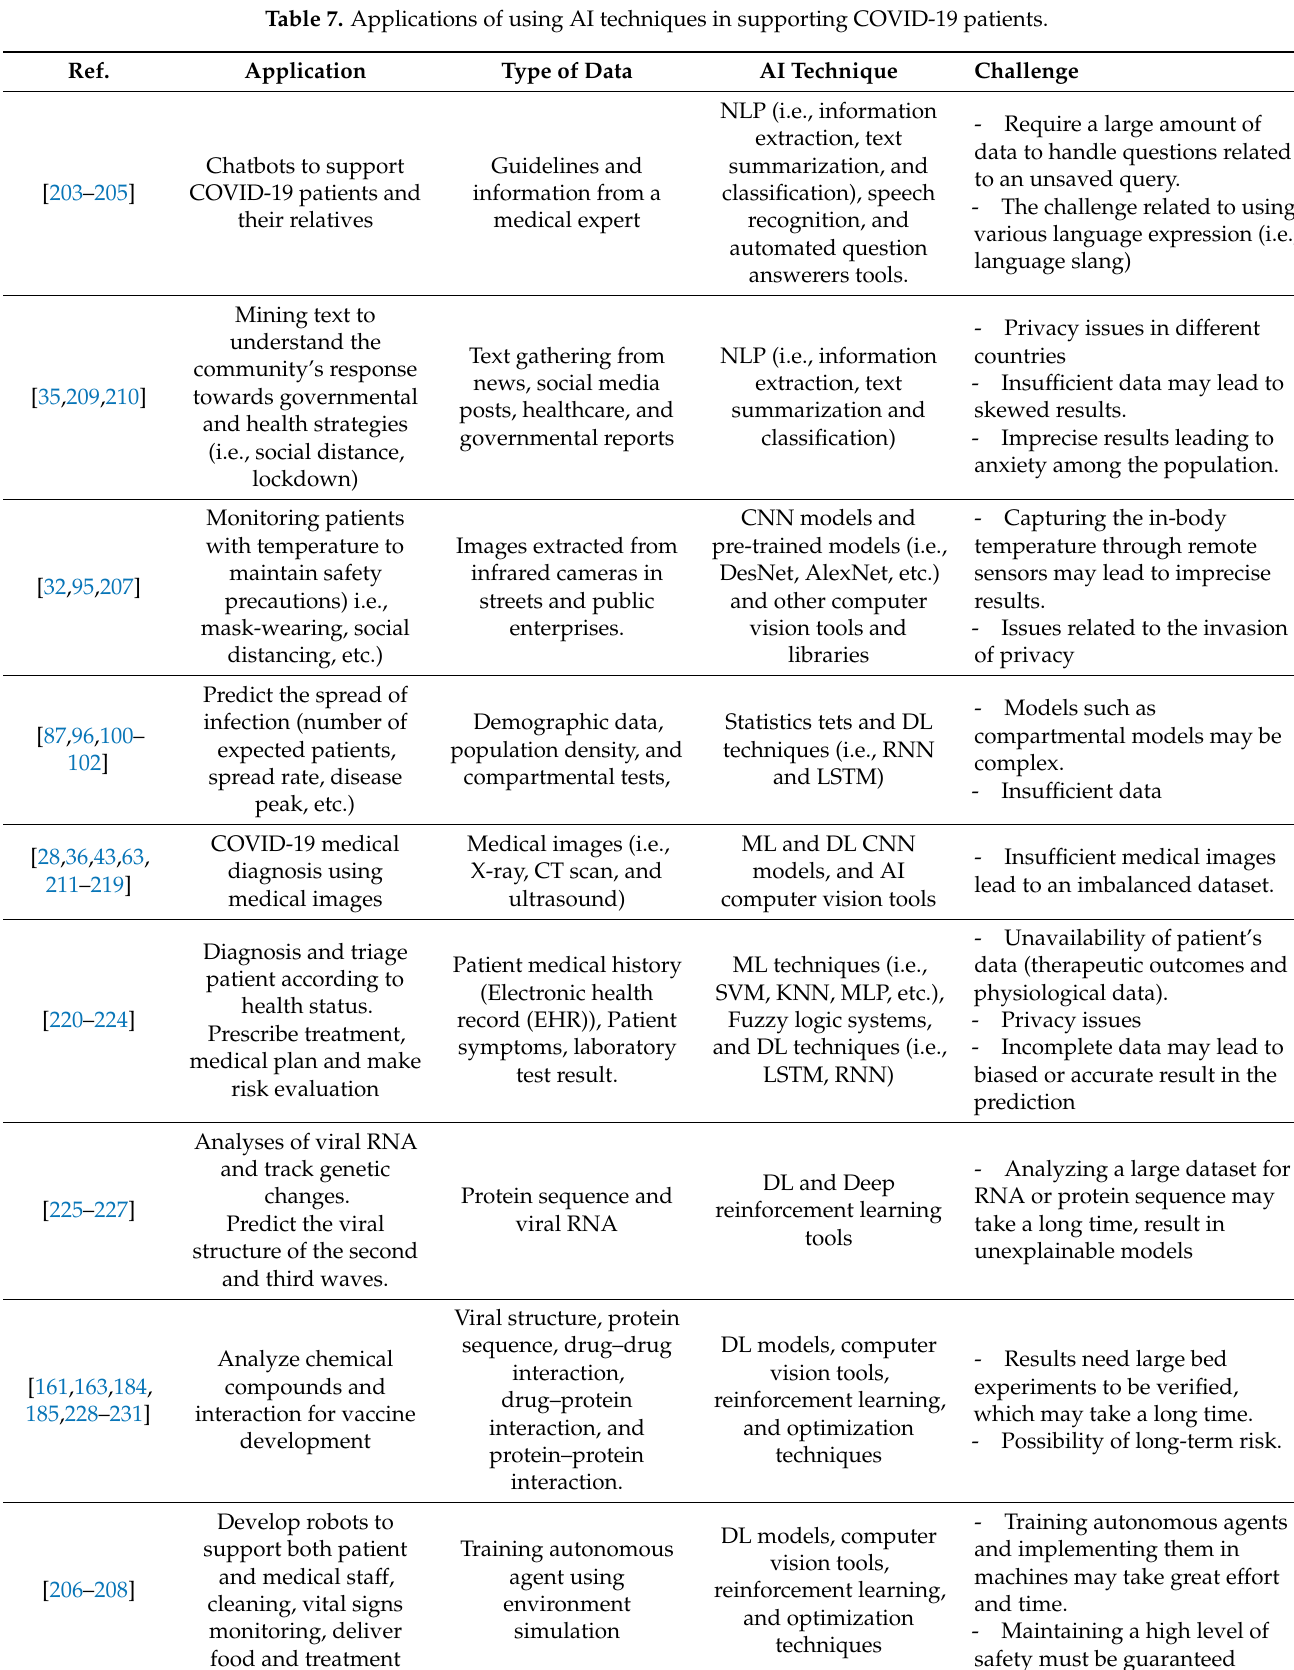
Table 7. Applications of using AI techniques in supporting COVID-19 patients.